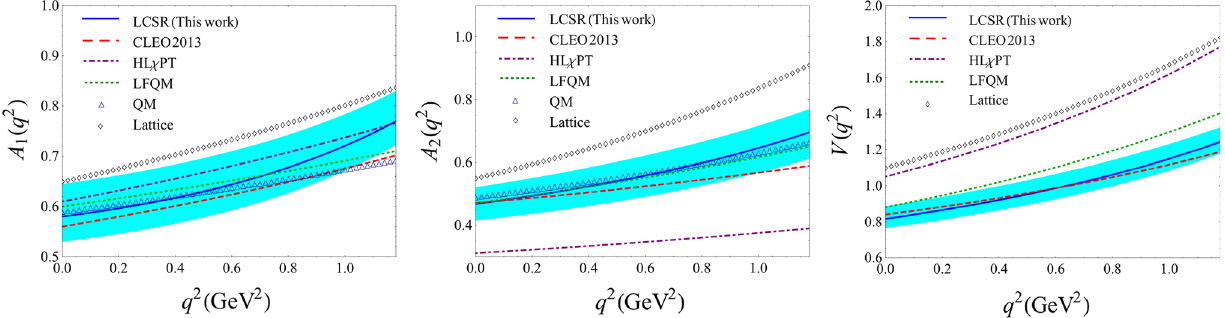
Fig. 7 The extrapolated D → ρ TFFs A 1 , 2 ( q 2 ) and V ( q 2 ) , in which the shaded bands are squared average of those from the mentioned error sources. As a comparison, we also present the central value of